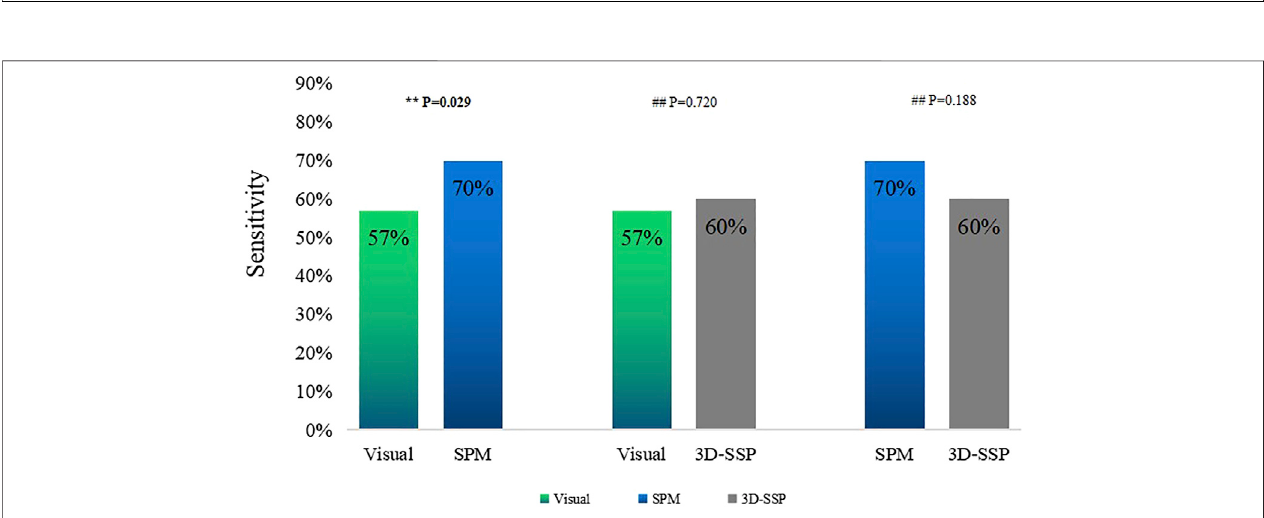
FIGURE 2 | Comparison of the sensitivities of visual assessment, SPM, 3D-SSP in detecting epileptic foci (**P ＜ 0.05, ##P ＞ 0.05).